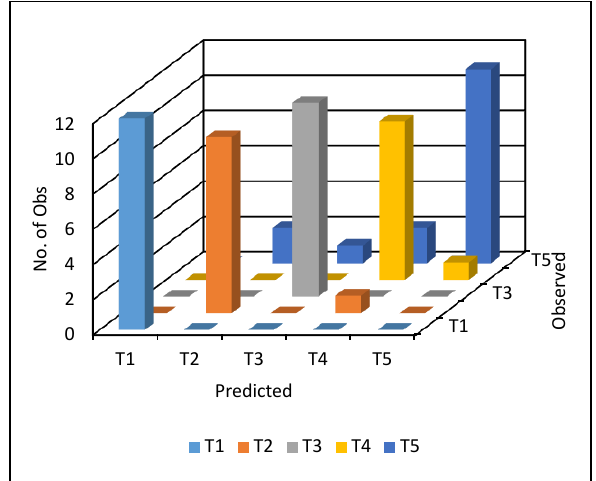
Figure 10. Important Variables Identified by RF Model